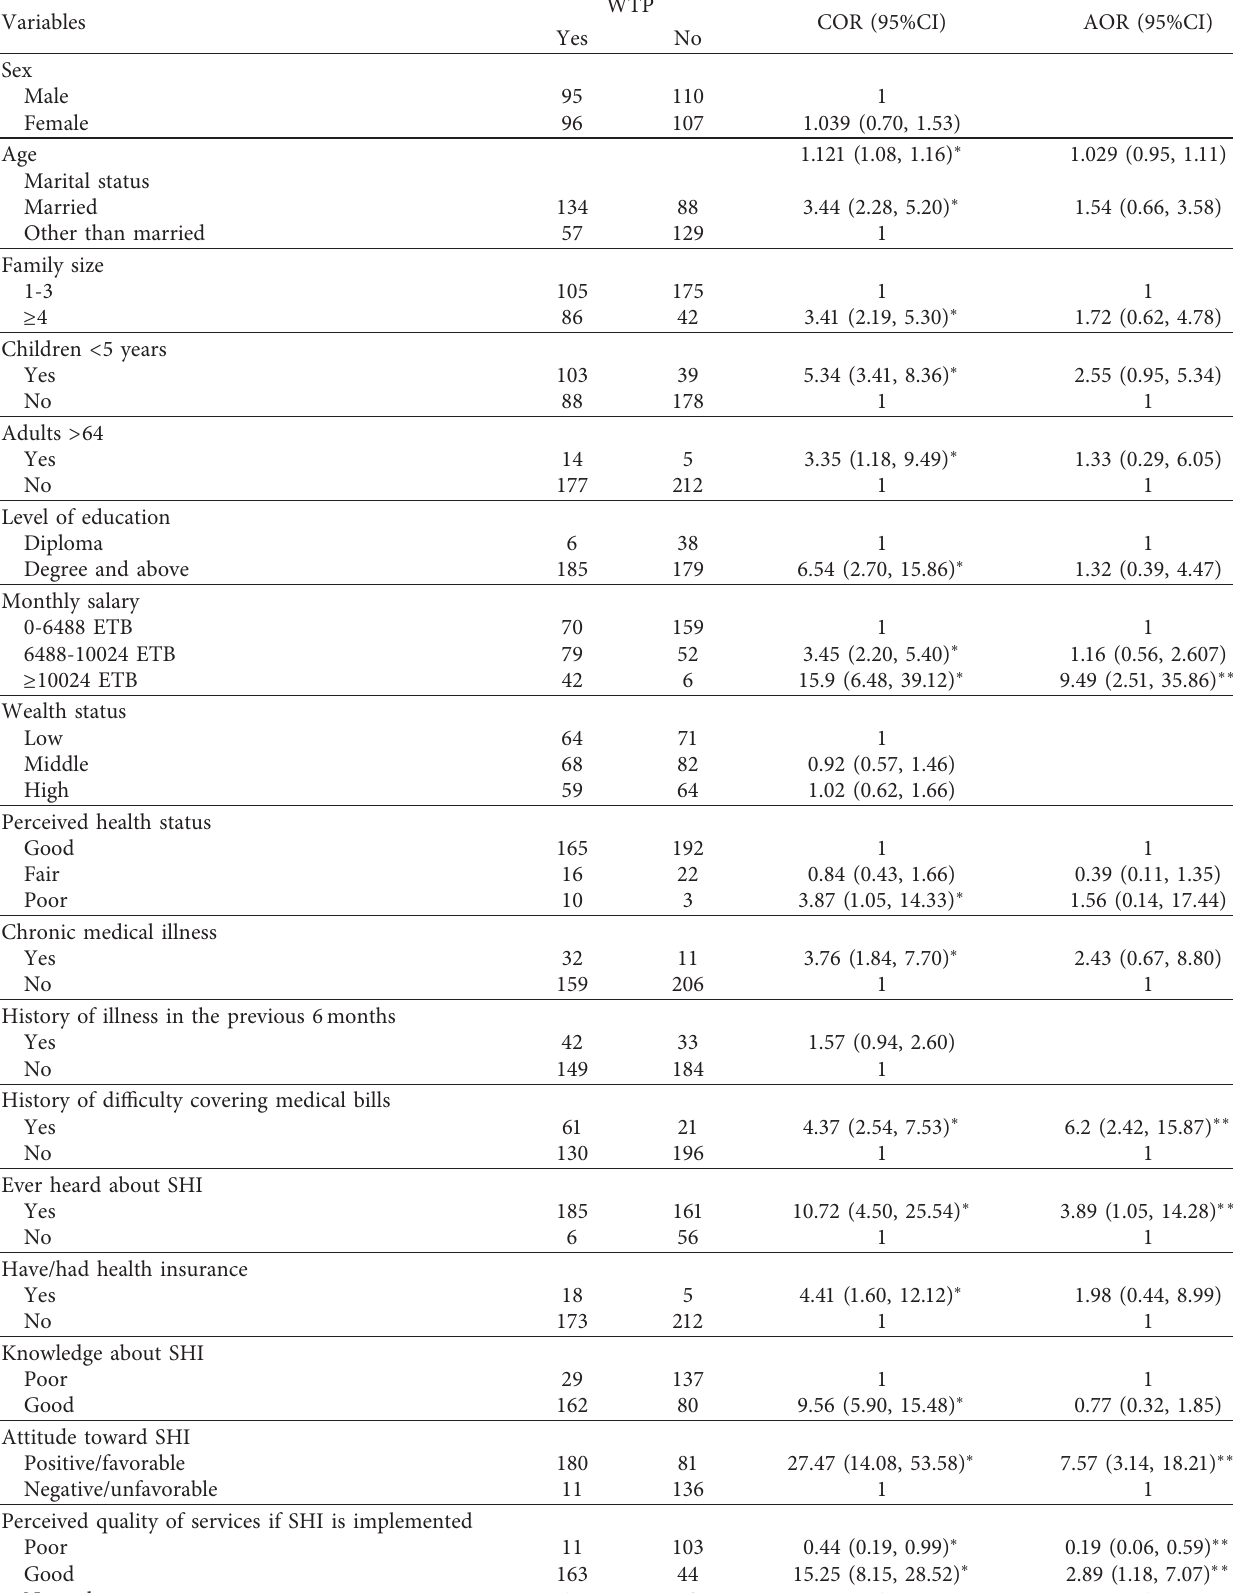
Table 3: Factors associated with acceptance for social health insurance among health professionals in government hospitals, Mekelle city, North Ethiopia,